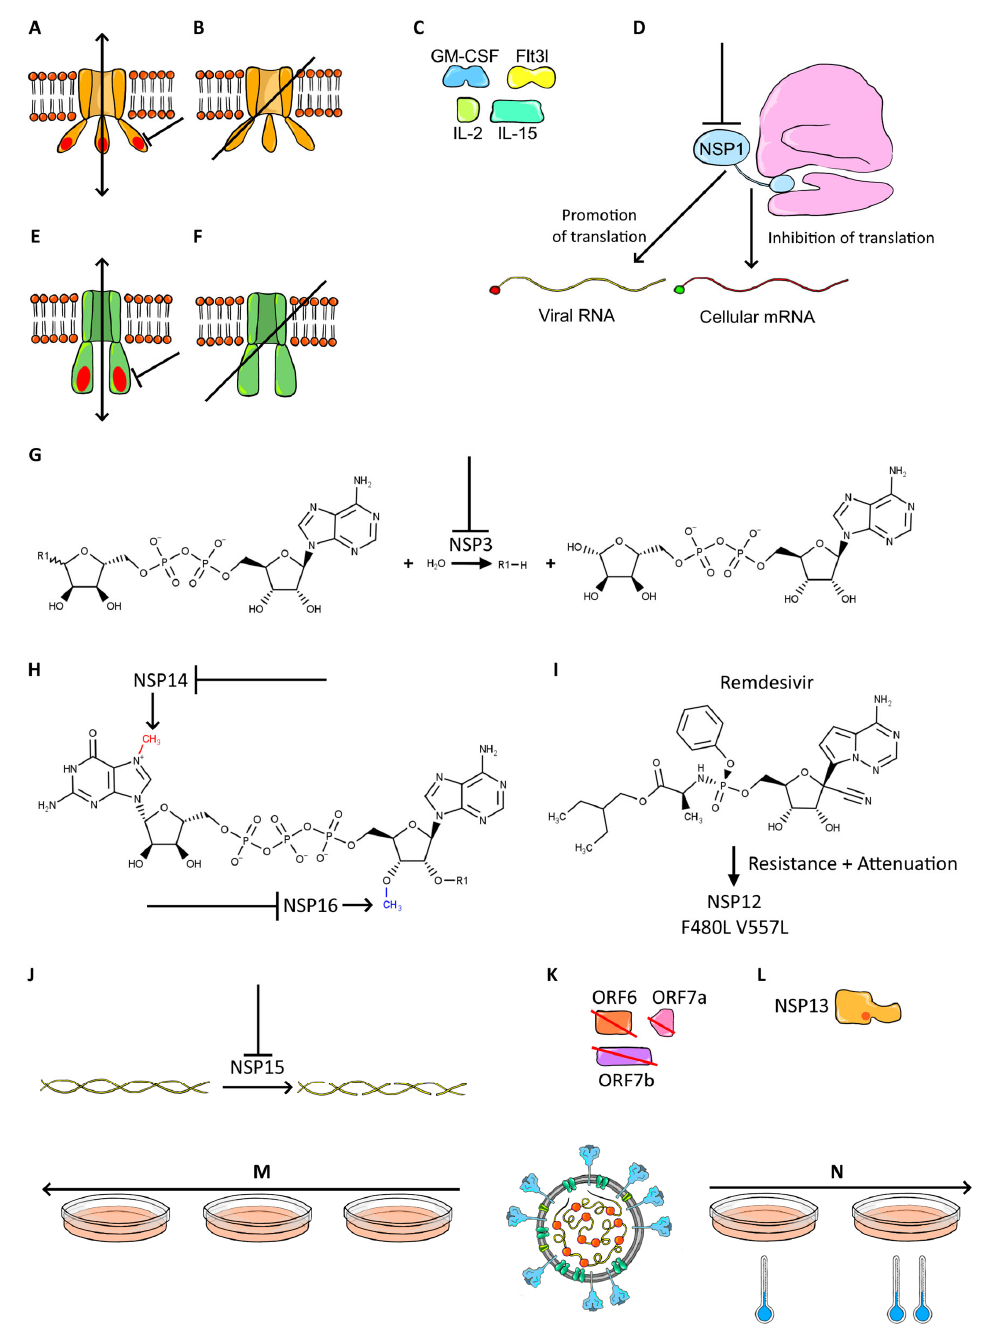
Figure 2. Attenuation strategies applicable to SARS-CoV-2 (Part 1). ( A ) Disruption of envelope ion channel and PDZ-binding domain. ( B ) Envelope protein deletion. ( C ) Coronavirus-encoded cytokines. ( D ) Disruption of NSP1 host-translation inhibitor. ( E ) Disruption of ORF3a ion channel and PDZ-binding domain. ( F ) ORF3a deletion. ( G ) Disruption of NSP3 macrodomain ADP-ribosylhydrolase activity. ( H ) Disruption of NSP14 N7-methyltransferase and NSP16 2 (cid:48) -O-methyltransferase. ( I ) NSP12 remdesivir-resistance mutations. ( J ) Disruption of NSP15 endonuclease. ( K ) Deletion of accessory proteins. ( L ) NSP13 A336V mutation. ( M ) Serial passage. ( N ) Cold adaptation.